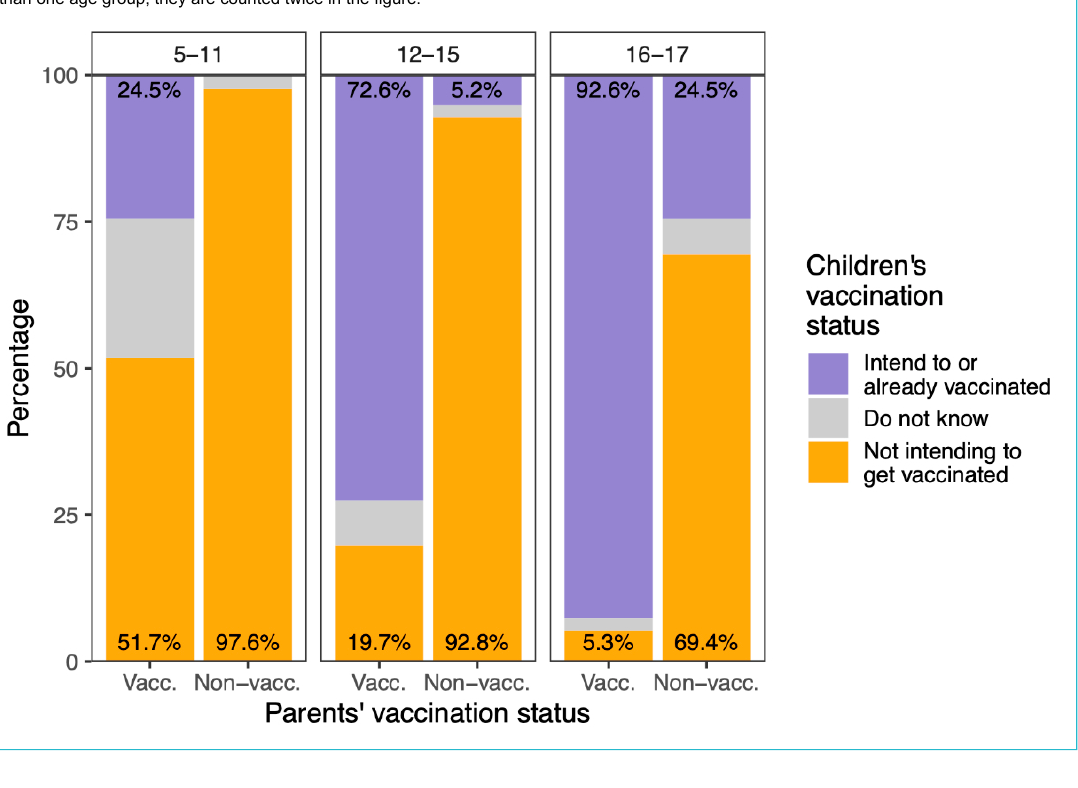
Figure 1: Parental intention to vaccinate children by age group and own vaccination status. Parental vaccination status is positively associat- ed with their intention to have their children vaccinated, across all age groups, though this association was weakest for the 5–11 years age group. “Vacc.” means parents having received at least one vaccine dose (those with at least one child aged 5–11 n = 705; 12–15 n = 548; 16–17 n = 339), and “Non-vacc.” refers to non-vaccinated parents (5–11 n = 126; 12–15 n = 97; 16–17 n = 48). If a parent has children in more than one age group, they are counted twice in the figure.